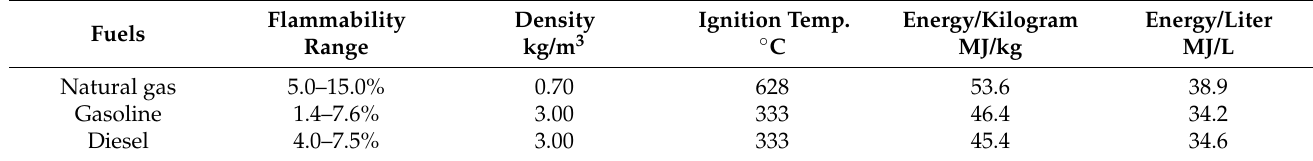
Table 1 indicates the properties of fuels used in the current study. Table 1. Properties of vehicle fuels used in this study adapted from